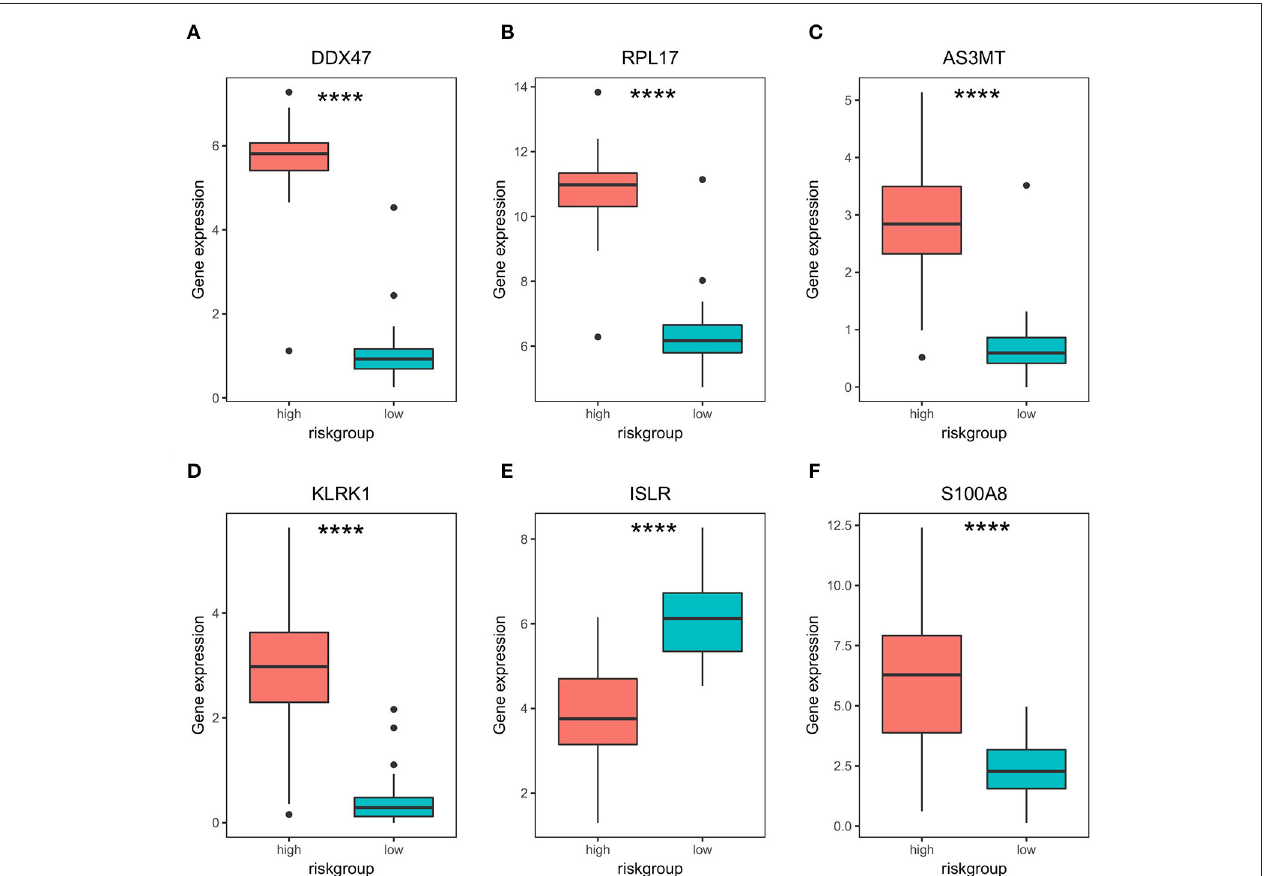
FIGURE 4 | Differential expression of bone metastasis prognostic genes in high- and low-risk groups. (A–F) Differential expression analysis of DDX47 , PRPL17 , AS3MT , KLRK1 , ISLR , and S100A8 in high- and low-risk groups. **** represents significant differences, p < 0.0001.